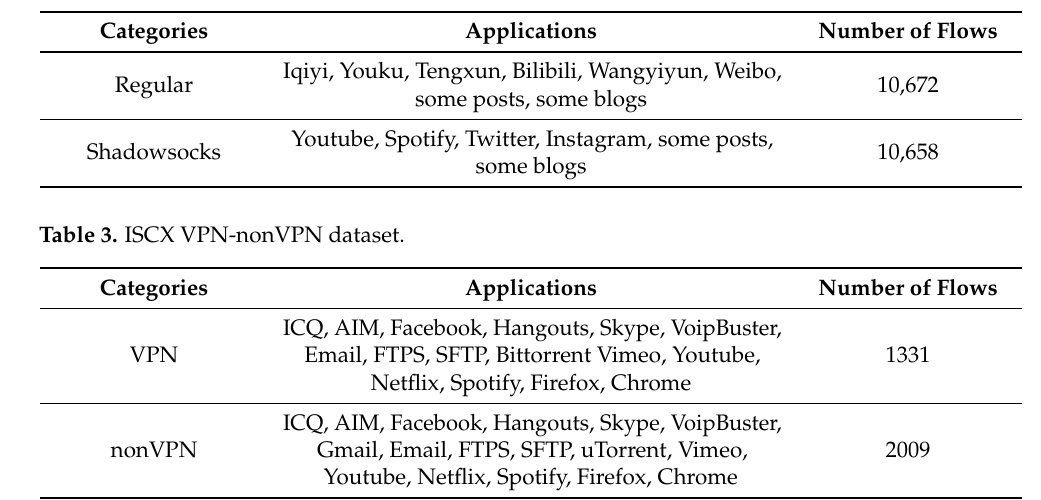
Table 2. Shadowsocks-Regular dataset.